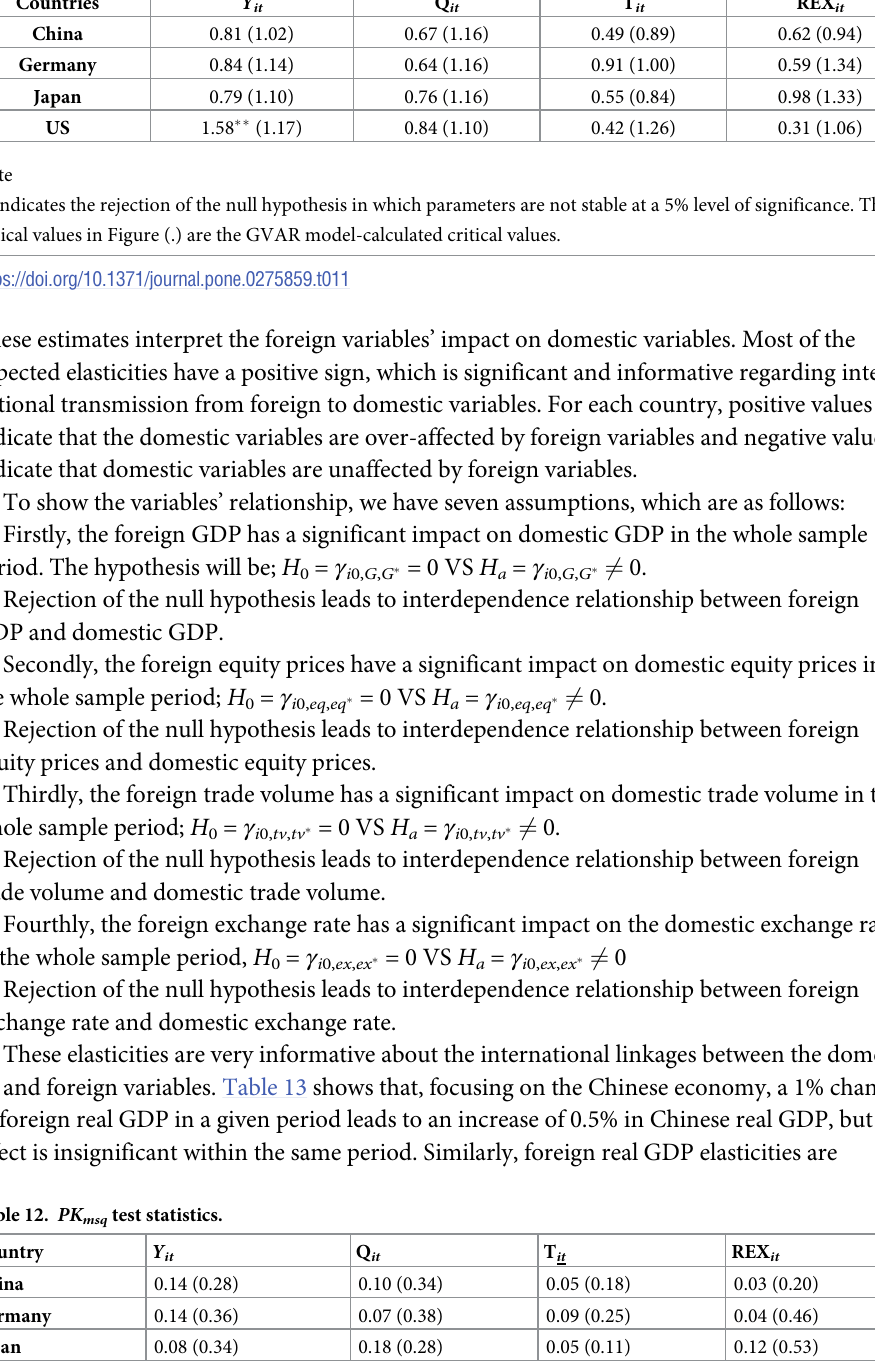
Note �� indicates the rejection of the null hypothesis in which parameters are not stable at a 5% level of significance. The critical values in Figure (.) are the GVAR model-calculated critical